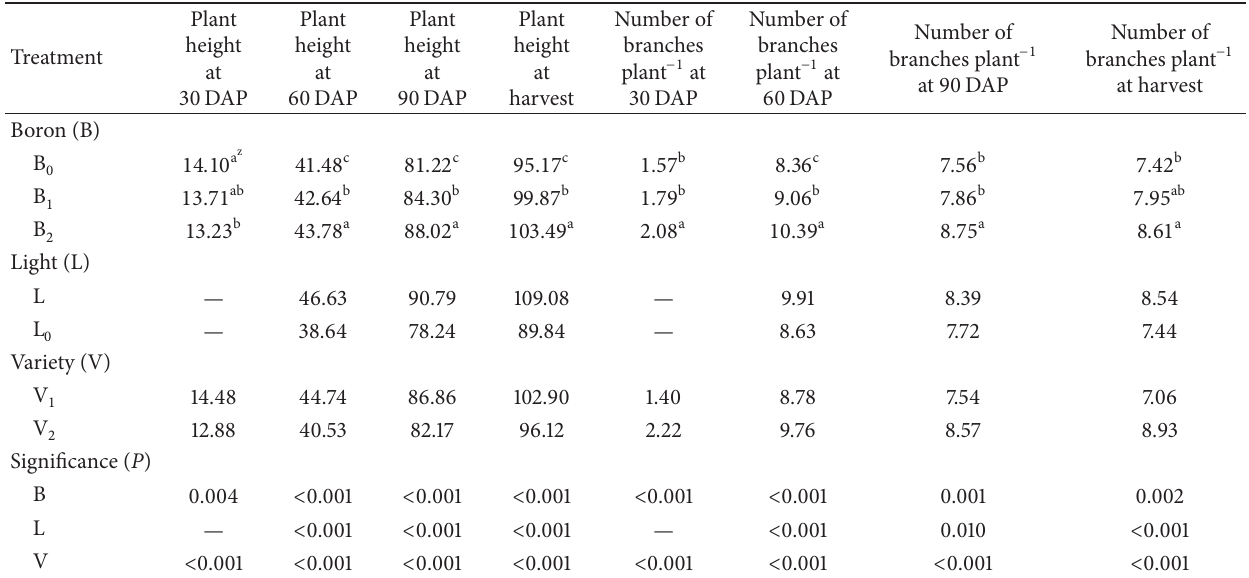
Table 3: Effect of boron and light on plant height and number of branches plant −1 in two peanut varieties (mean of two trials).